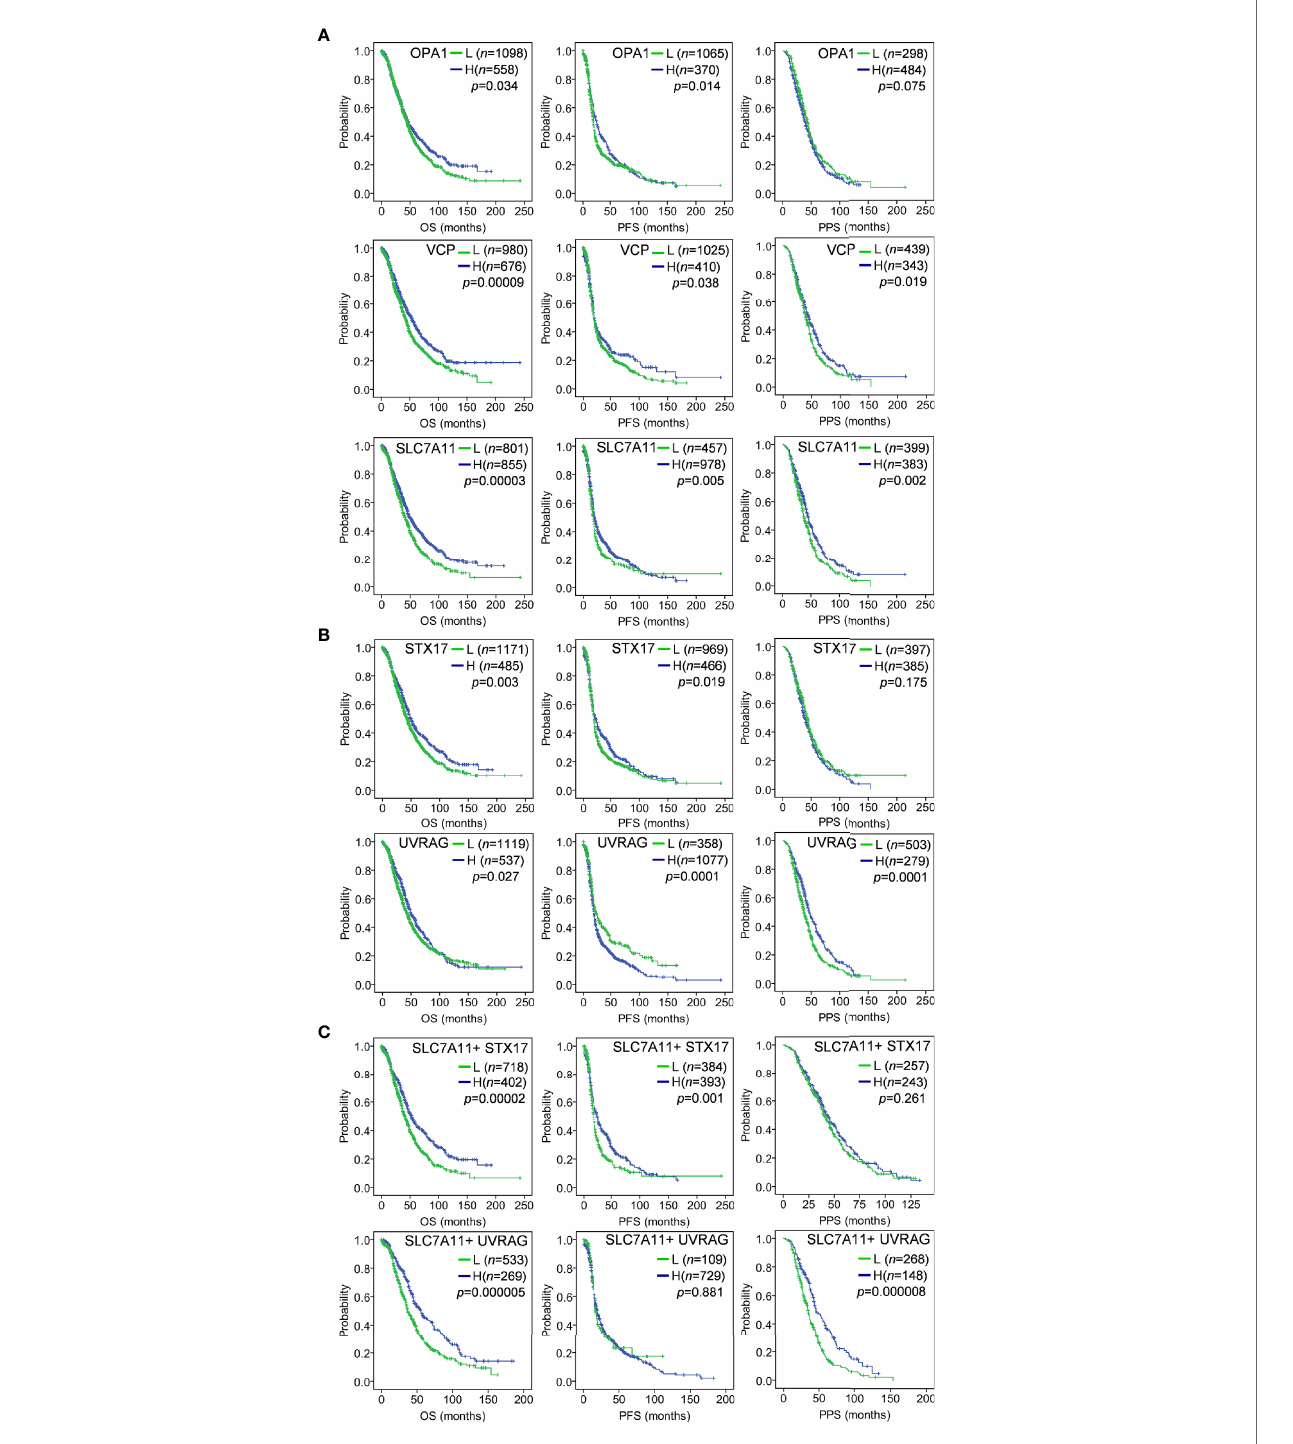
FIGURE 2 | Kaplan – Meier analysis of gene expression with OC survival in a large sample of 1815 OC patients using the Kaplan – Meier Plotter tool. The auto- selected best cutoff value was used to dichotomize gene expression into high (H) and low (L). (A) Low expression of OPA1, VCP and SLC7A11 predicted poor OS, PFS and PPS; (B) As ceRNA target of SLC7A11, STX17 and UVRAG suppression predicted poor OS, PFS and/or PPS; (C) The combination of SLC7A11 expression with STX17 or UVRAG was associated with poor OS, PFS and/or PPS. OS, overall survival; PFS, progression-free survival; PPS, post- progression